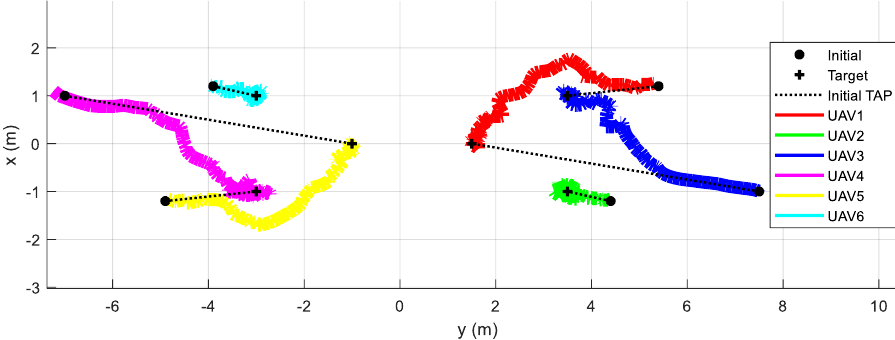
Figure 16. Trajectories of six quadrotors planned by the proposed formation transformation algorithm.